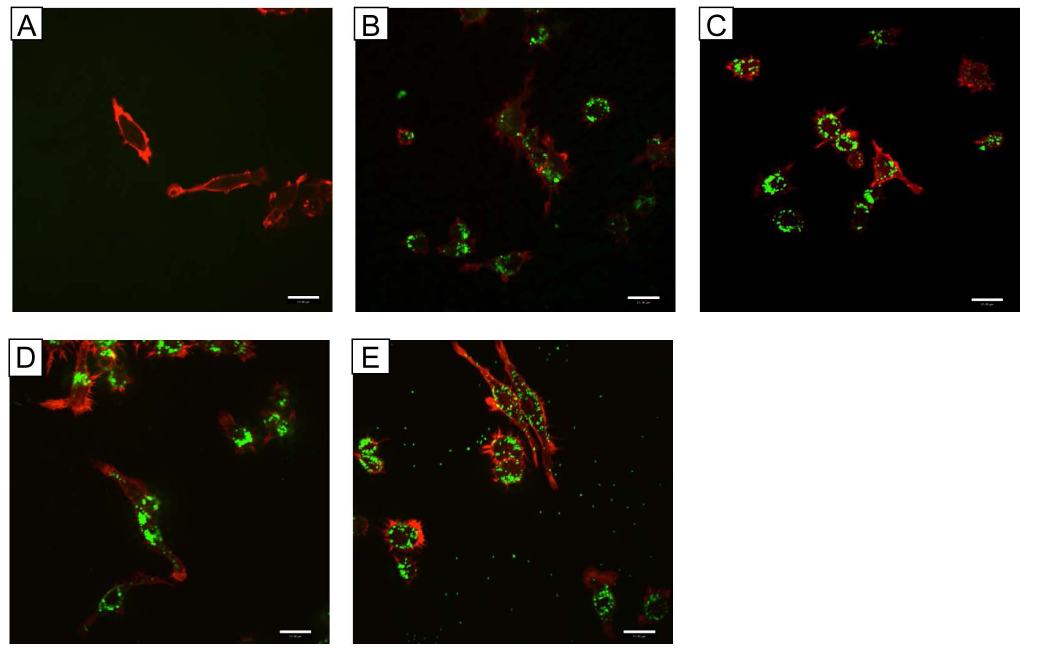
Figure 6. High-resolution imaging with rhodamine phalloidin-labeled actin shows NP-containing cell morphological. RAW incubated A) control, B) 30 nm, C) 50 nm, D) 100 nm, and E) 500 nm NPs at 37 u C for 4 h. The cells were fixed and labeled with phalloidin. Two-color immunofluorescence confocal images were obtained for NPs (green) and G-actin (red).